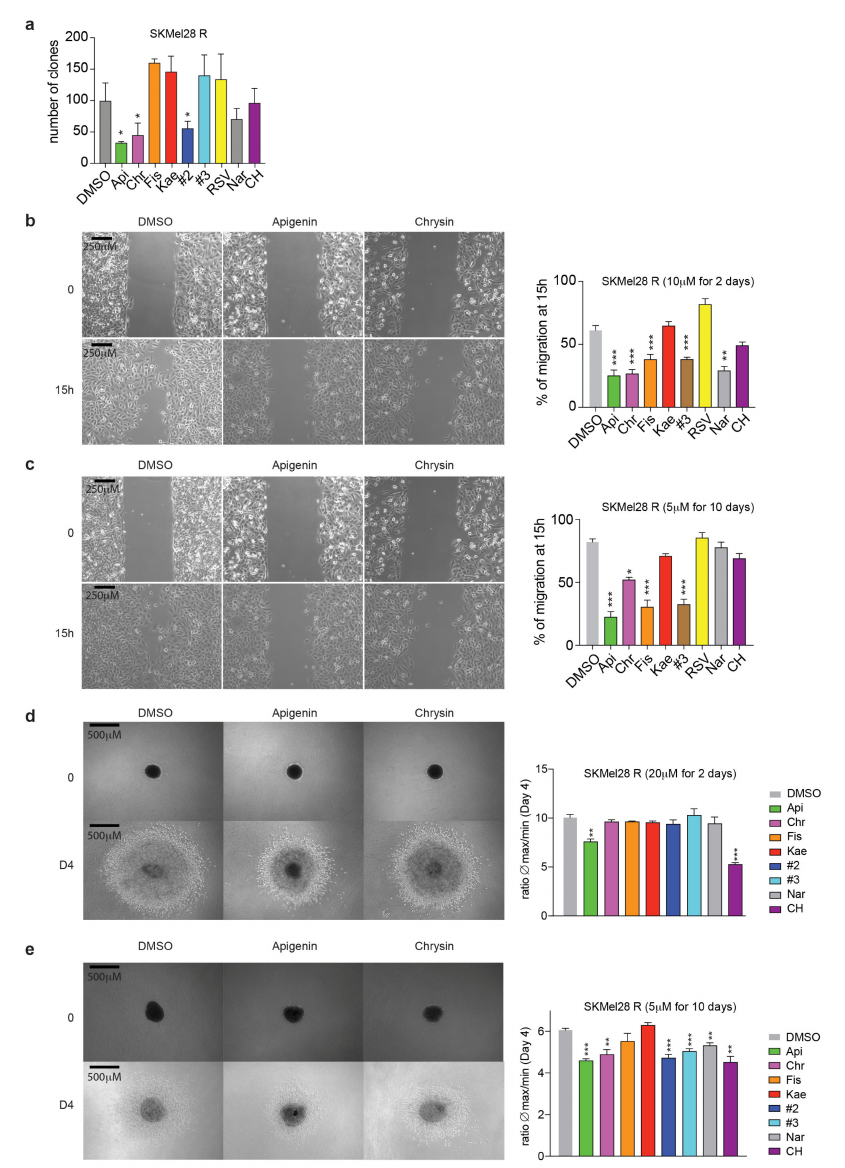
Figure 4. Flavonoids prevent the migration and invasion of BRAFi-resistant melanoma cells. ( a ) Clonogenic assays were performed to evaluate proliferation using SKMel28R cells exposed to flavonoid treatment (10 µ M) and cultivated for 12 days. The histogram shows the mean number ± sem. of colonies ( n = 3). ( b , c ) Wound-healing assays were performed using IBIDI ® chambers to evaluate the role of flavonoids on cell migration. Images of the wound were acquired at a 5 × magnification with an Axio Vert.A1 inverted microscope (Carl Zeiss). The histogram shows the mean ± sem; wound closure determined by measuring the distance between the edges of the wound at time 0 and 15 h ( n = 3–6), unpaired t -tests with the Sidak–Bonferroni method. SKMel28R cells were treated with 10 µ M flavonoids. Scale bar 250 µ m. ( b ) for two days (short term) or 5 µ